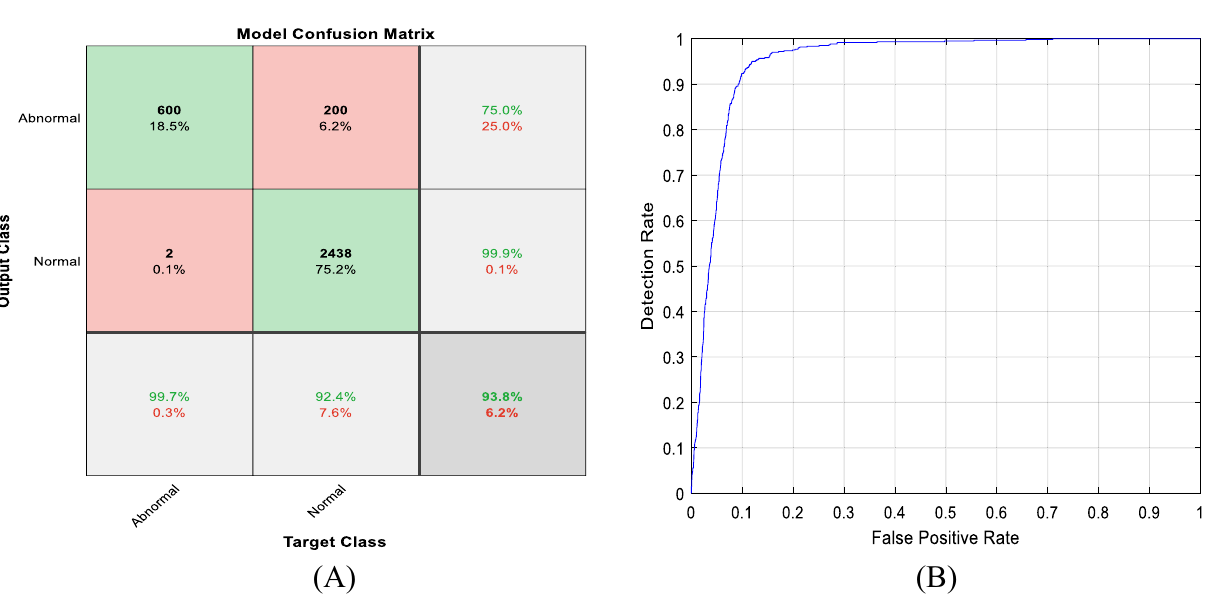
Figure 14. ( A ) Binary classification data model confusion matrix. ( B ) Receiver operating characteristic (ROC)